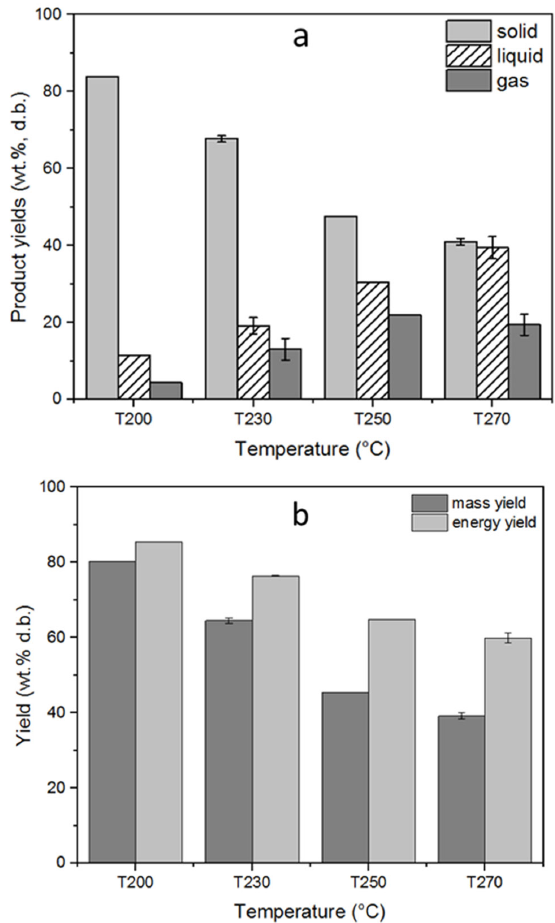
Figure 3. Influence of the torrefaction temperature on ( a ) solid, liquid, and gas yields ( b ) mass and energy yields of torrefaction process. The standard deviations were indicated for triple analyses carried out for T230 and T270.